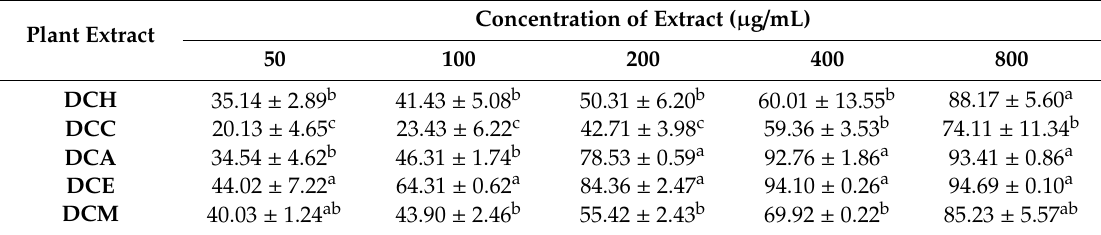
Table 2. Percentage of 2,2-diphenyl-1-picrylhydrazyl (DPPH) free radicals scavenged by the extracts at di ff erent concentrations.